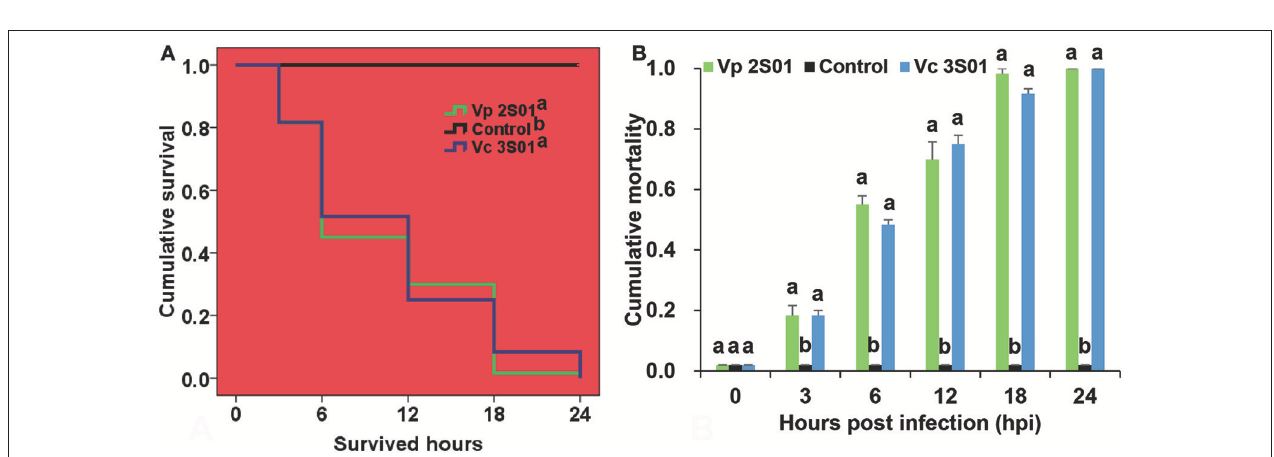
FIGURE 2 | Mortalities induced in the immersion bioassay of Litopenaeus vannamei. (A) Survival plots of the shrimp in each group. Survival patterns not sharing a common superscript letter following the pattern curve legends were significantly different from each other ( P < 0.05). (B) Mortality of shrimp in each group. Immersion bioassay was performed in triplicate. Error bars indicate standard error of measurement (SEM). Different lowercase letters indicate significant differences ( p <